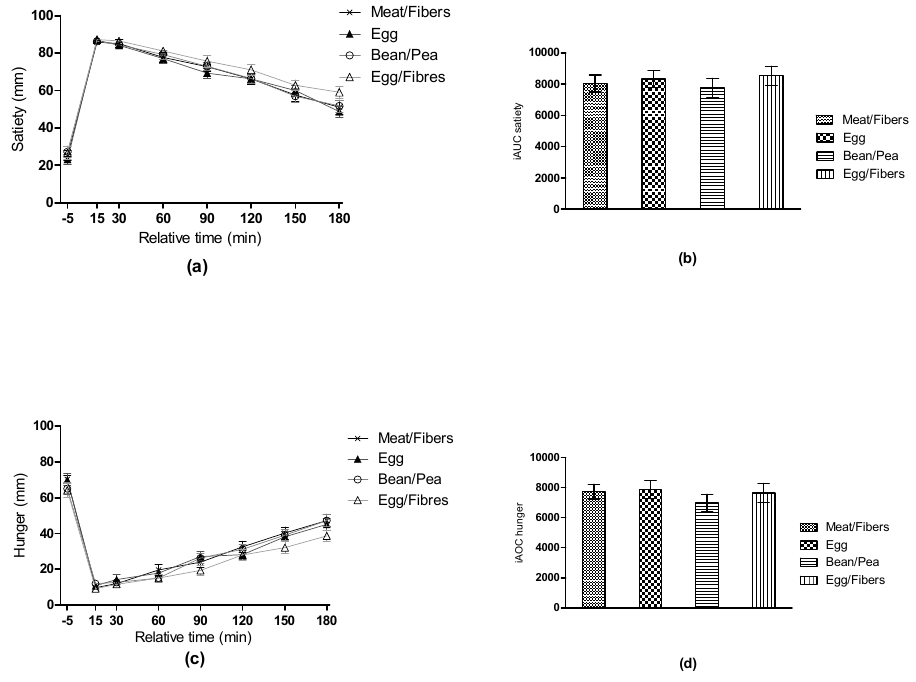
Figure 3. Mean unadjusted three-hour changes in ( a ) satiety, ( c ) hunger, and ( b ) corresponding incremental area under the curve (iAUC) and ( d ) incremental area over the curve (iAOC), respectively. Data are presented as mean ± SEM. Both as repeated measures, analyzed using mixed linear models including a time * meal interaction, and iAUC or iAOC, analyzed using mixed linear models including meal as a fixed effect. No differences were found in satiety and hunger across meals (all p > 0.05).